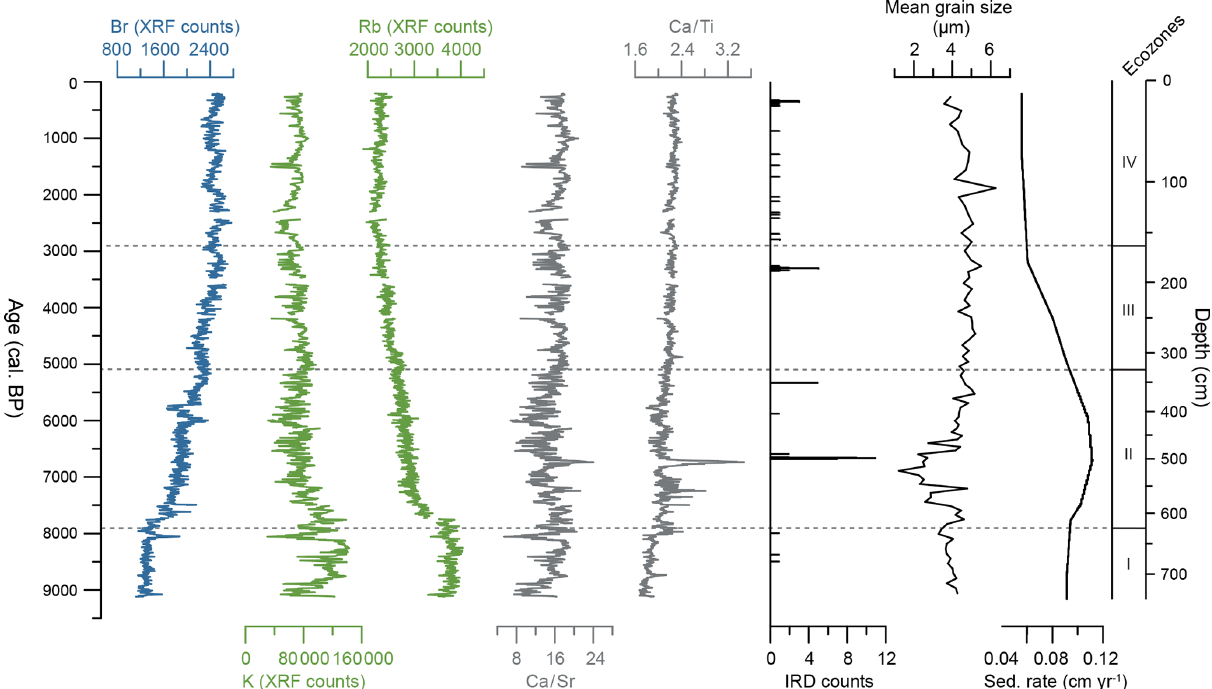
Figure 6. From left to right: X-ray fluorescence data, IRD concentration, mean grain size expressed in micrometres (µm) (Caron et al., 2018), and sedimentation rate in core AMD14-204C. The benthic foraminiferal ecozones are given on the right side of the plot. Gaps in data indicate missing